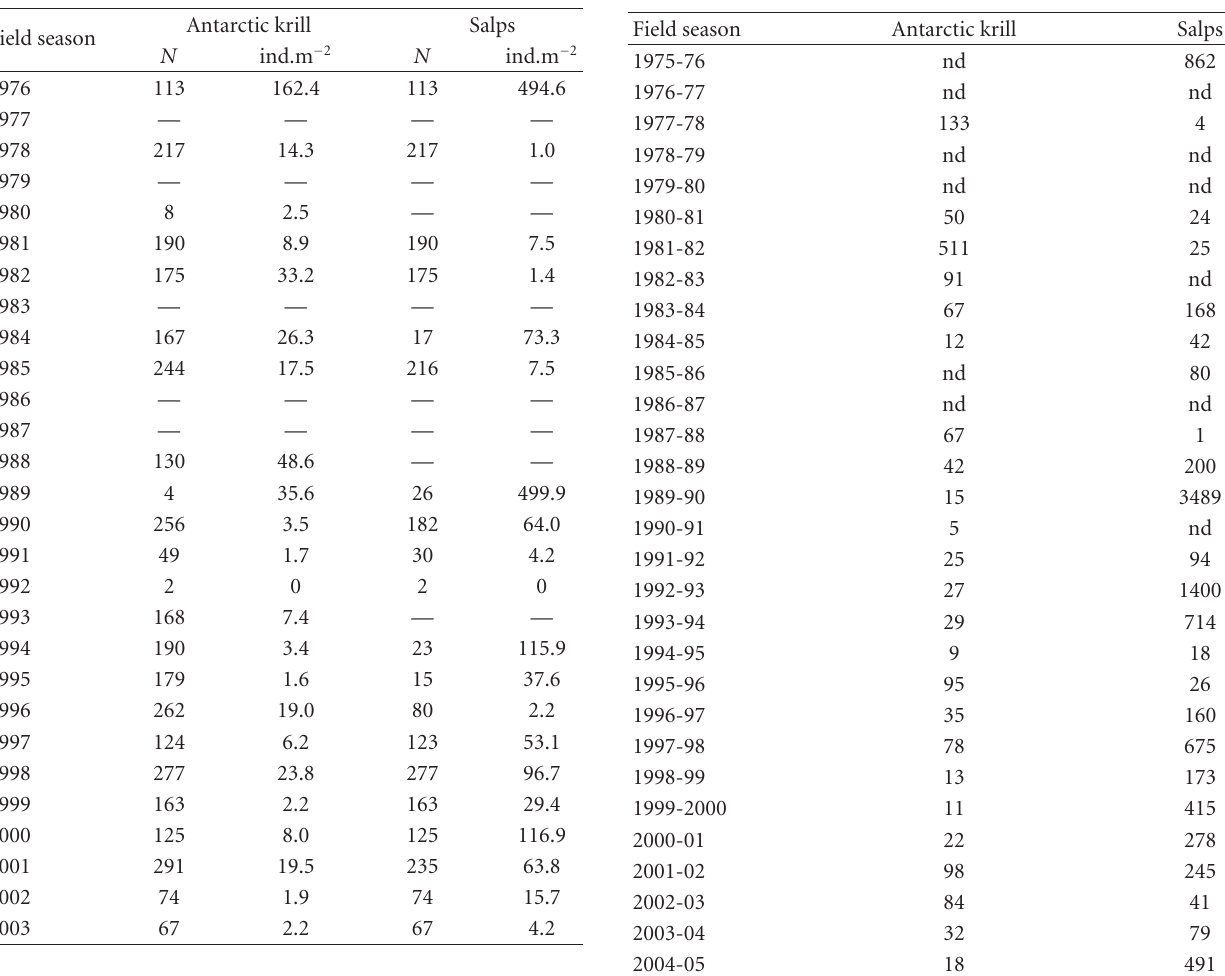
Table 2: Mean abundance of Antarctic krill and salps in the study area averaged for January to March. Source: KRILLBASE [8]. N : number of stations.